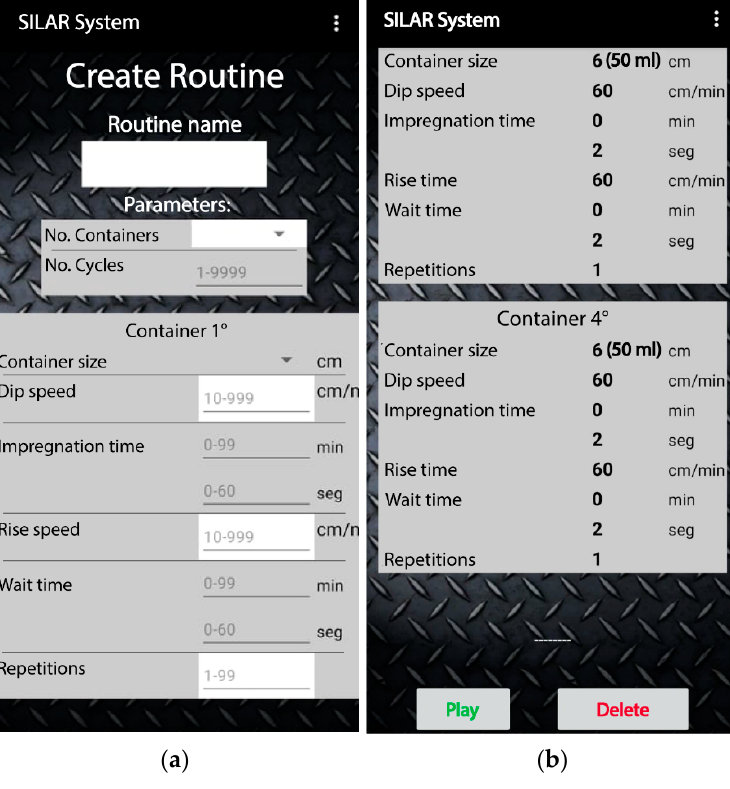
Table 4. Size of the data frame used in the mobile app in function of the number of used containers.